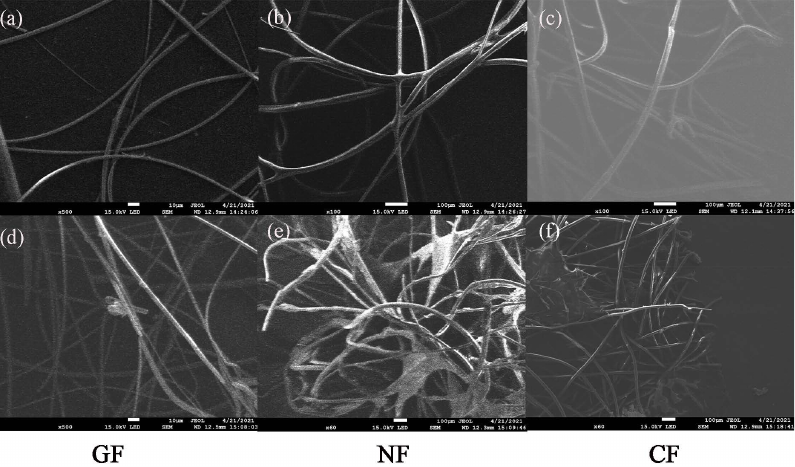
Figure 3. Photographs of non-treated (NT, upper ) and triclosan-treated (TT, lower ) GF, NF and CF filter fibers by SEM. (( a )-GF (NT); ( b )-NF (NT); ( c )-CF (NT); ( d )-GF (TT); ( e )-NF (TT); ( f )-CF